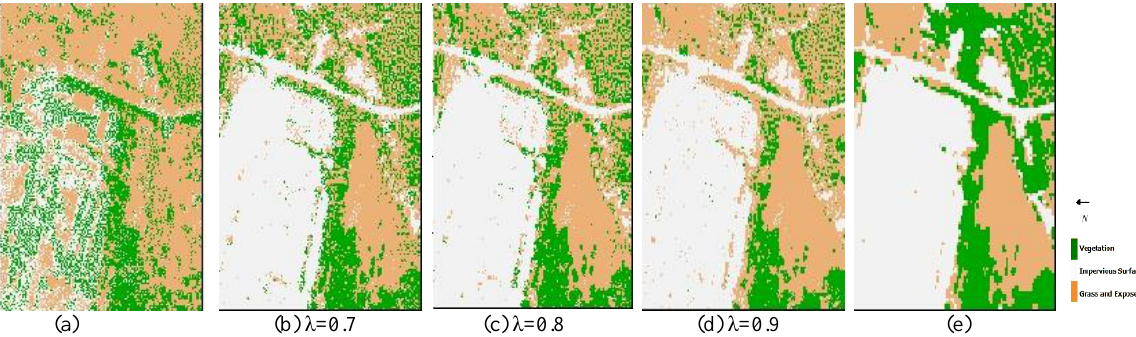
Fig.4. Initial SRM (a) Optimum SRM generated using conventional class definitions for λ=0.7(b), λ=0.8(c), λ=0.9(d) respectively and the MLC classified reference image (e).